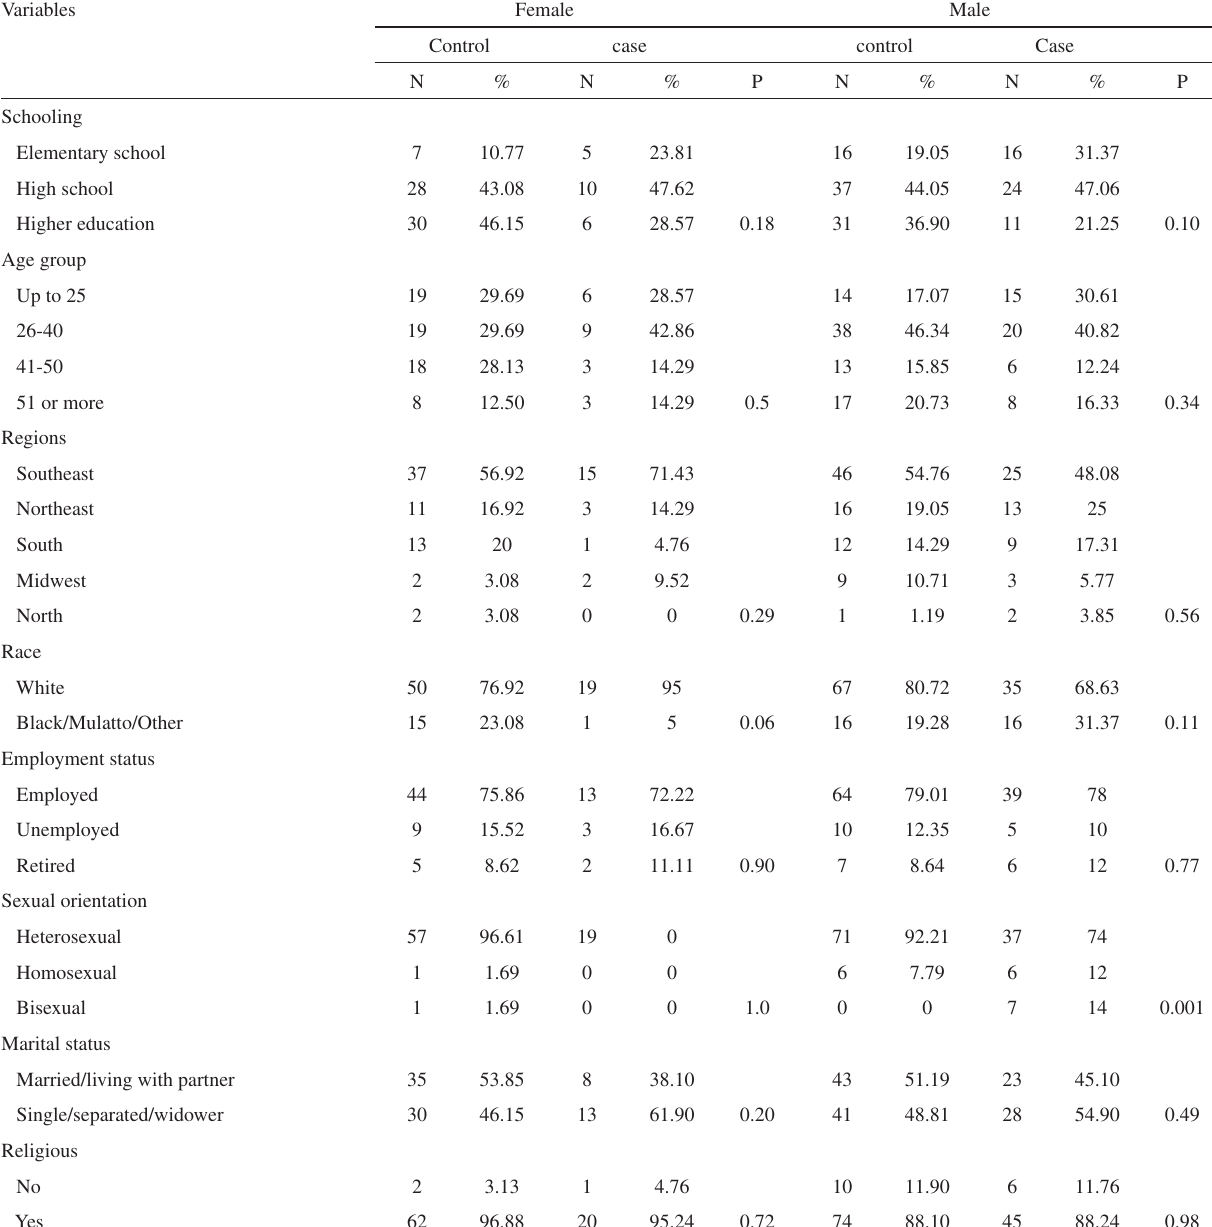
Table 1 - Distribution of sociodemographic characteristics in controls and cases.